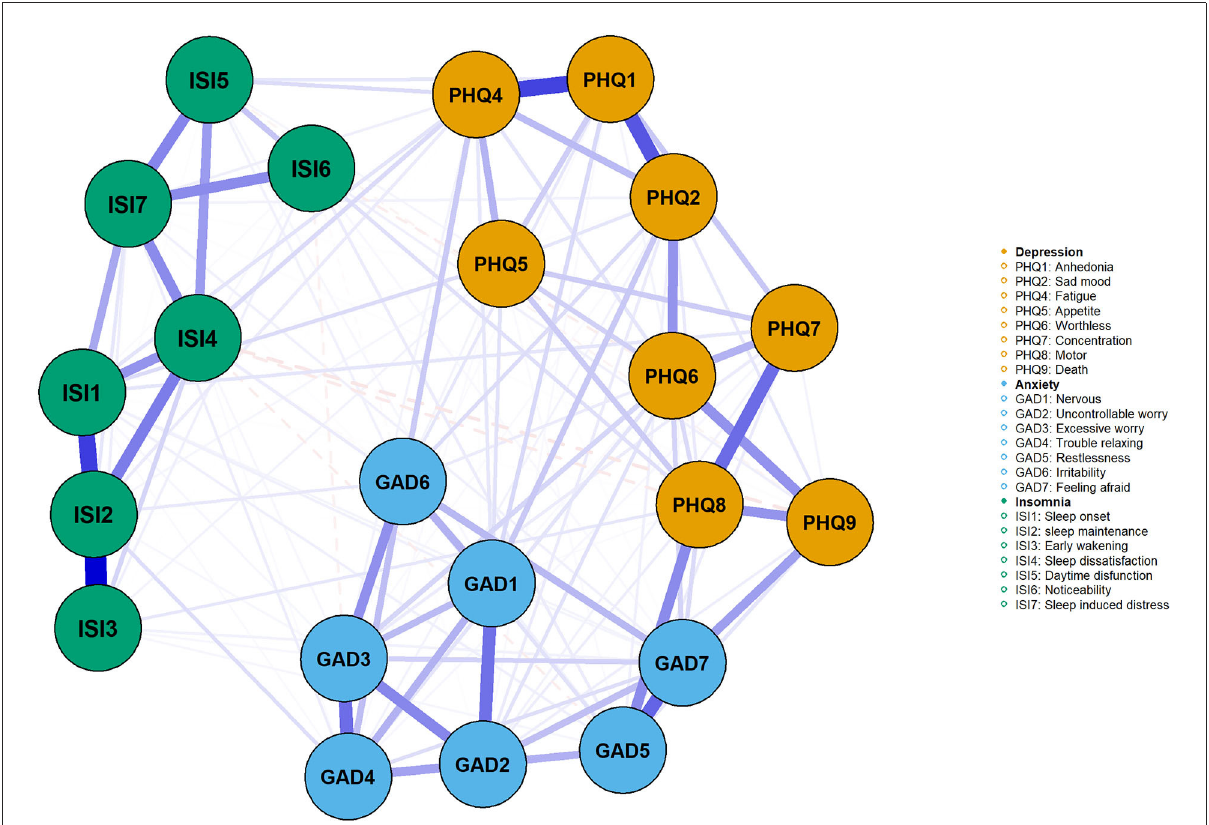
FIGURE1 The network of insomnia, depression, anxiety symptoms in nurses. The green, blue, and orange nodes represented insomnia, anxiety, and depression symptoms, respectively. The blue edges represented positive association, while the red represented the negative association. Thicker edges suggested stronger